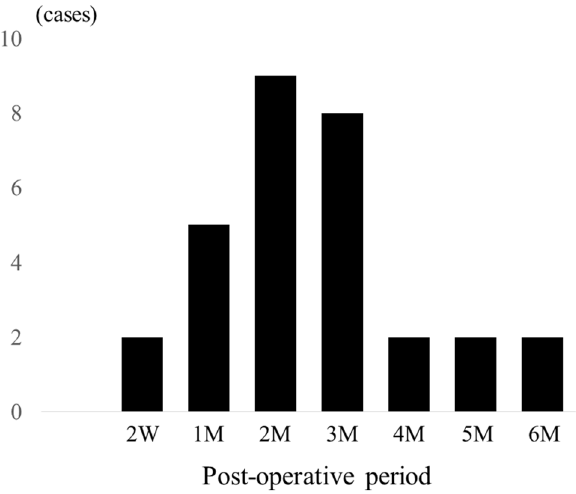
Figure 1. Distribution of onset period of anterior blepharitis after cataract surgery. The onset time for most of the anterior blepharitis cases was 2 to 3 months postoperatively. (W: week, M: month).